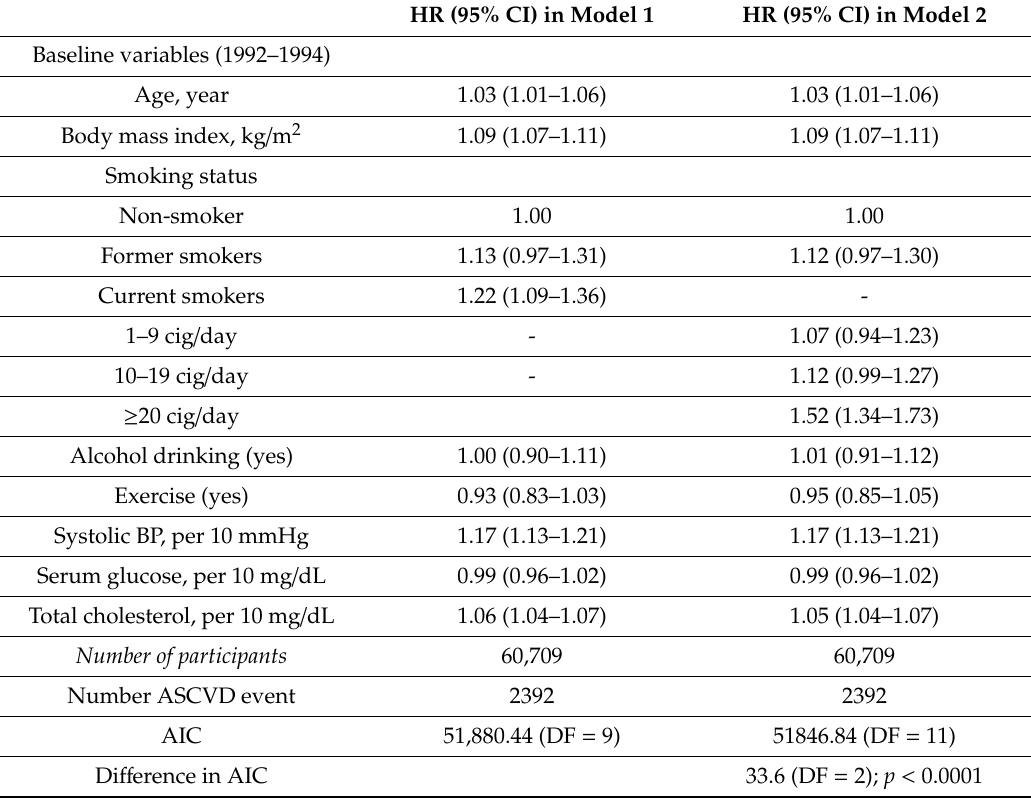
Table 2. Basic model with e ff ect of smoking status and amount of smoking on atherosclerotic cardiovascular disease (ASCVD) events, using Cox proportional hazard